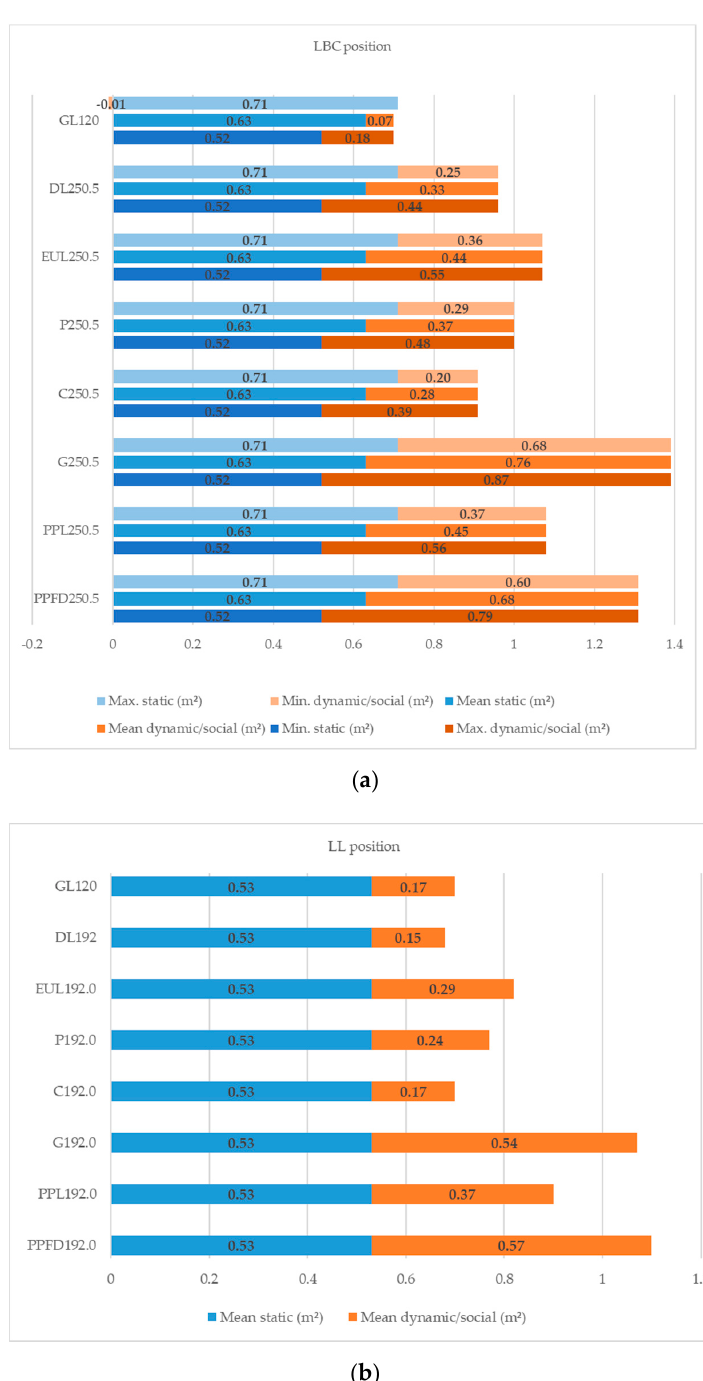
Figure 3. Static and social/dynamic space for sows in lying position ( a ) LBC and ( b ) LL with a different minimum space available (with LBC = Lying in belly chest position, LL = Lying in the lateral position, Min = minimal value, Max = maximal value, static = static space, social/dynamic = social and dynamic space, abbreviations on the y -axis: see Table